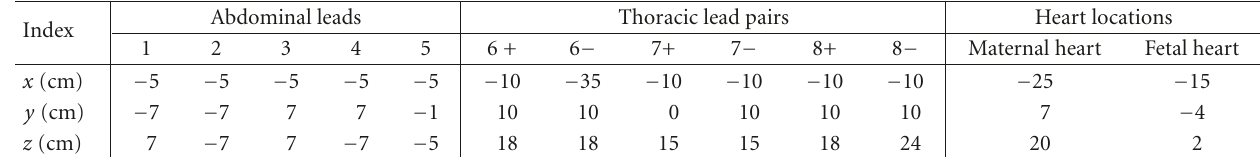
Table 5: The simulated electrode and heart locations. ∗